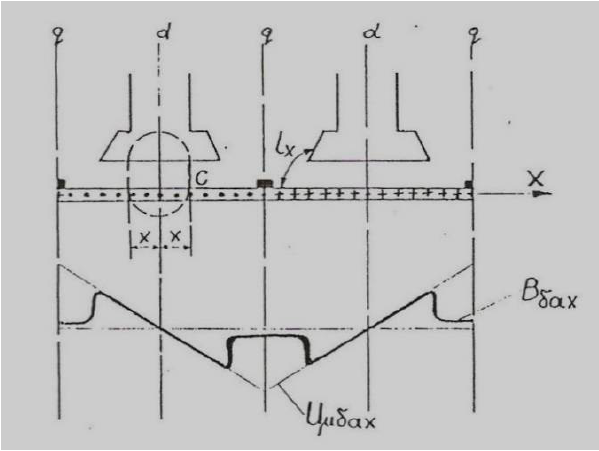
Figure 3. Magnetic induction B δαx from armature current when the brushes are placed in axis q .